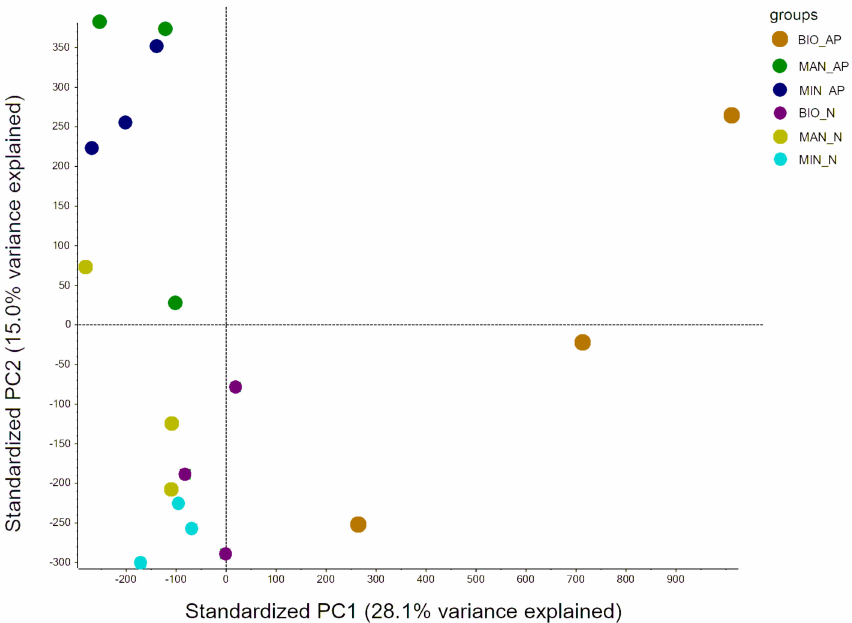
Figure 7. A principal component analysis (PCA) biplot of data on metabolic features of courgette fruits of Astra Polka (AP) and Nimba (N) cultivars grown in horticultural systems with commer- cial organic fertilizer (BIO), manure (MAN), and mineral (MIN) fertilizer. PC1, the first principal component; PC2, the second principal